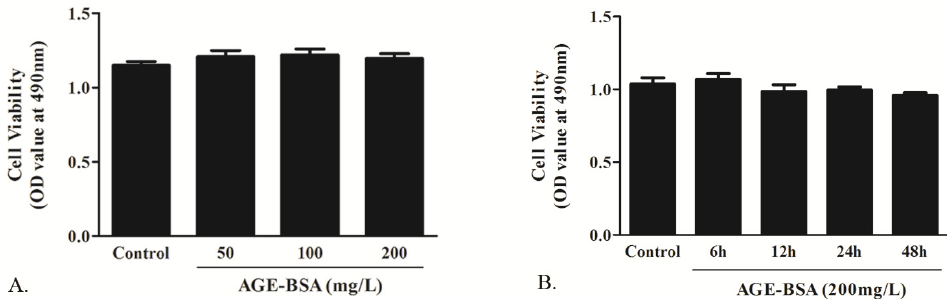
Figure 2. Effect of AGE on the cell viability determined by MTT assay. ( A ) Cells were treated with AGE at the concentration of 50, 100 and 200 mg/L for 24 h; ( B ) Cells were treated with AGE at 200 mg/L for 6, 12, 24 and 48 h respectively. n = 5 wells in each individual experiment. * p < 0.05 vs . control; Data are mean ± SD.